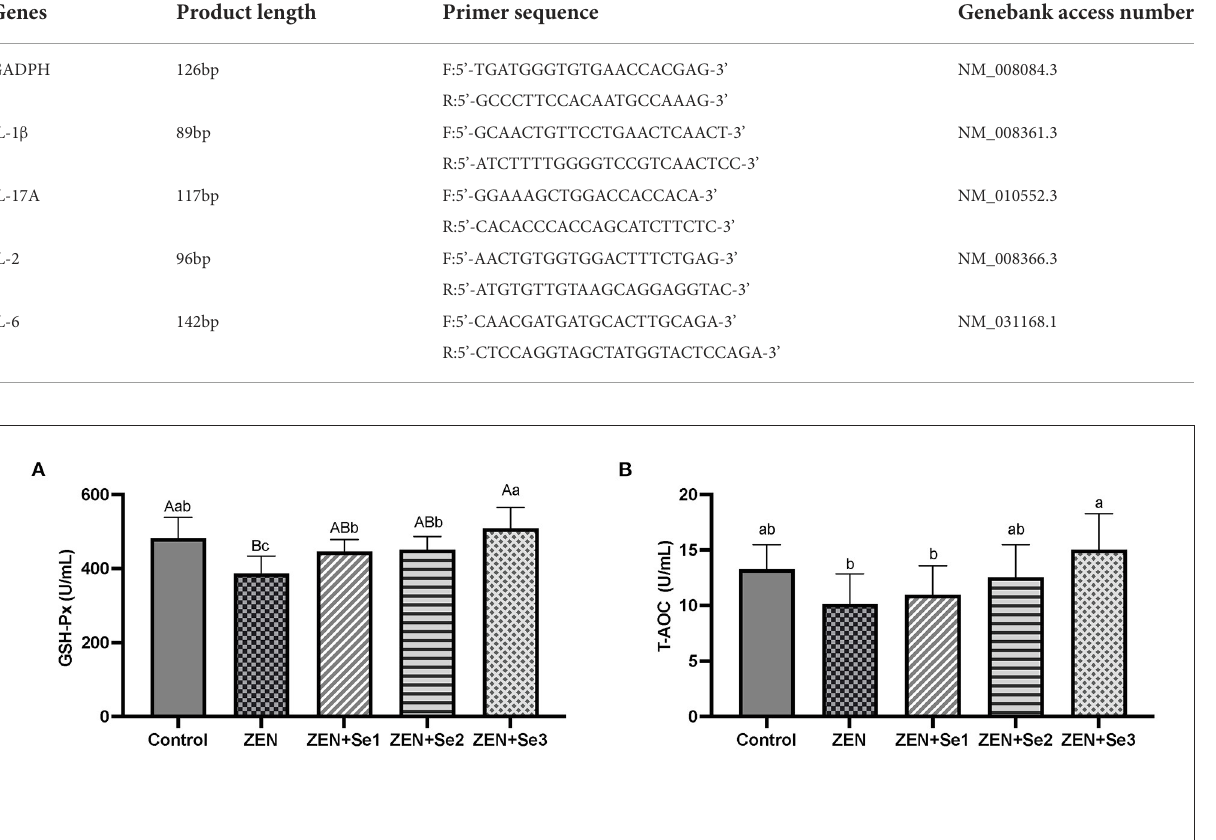
those of mice in the ZEN group ( P < 0.01 or P <